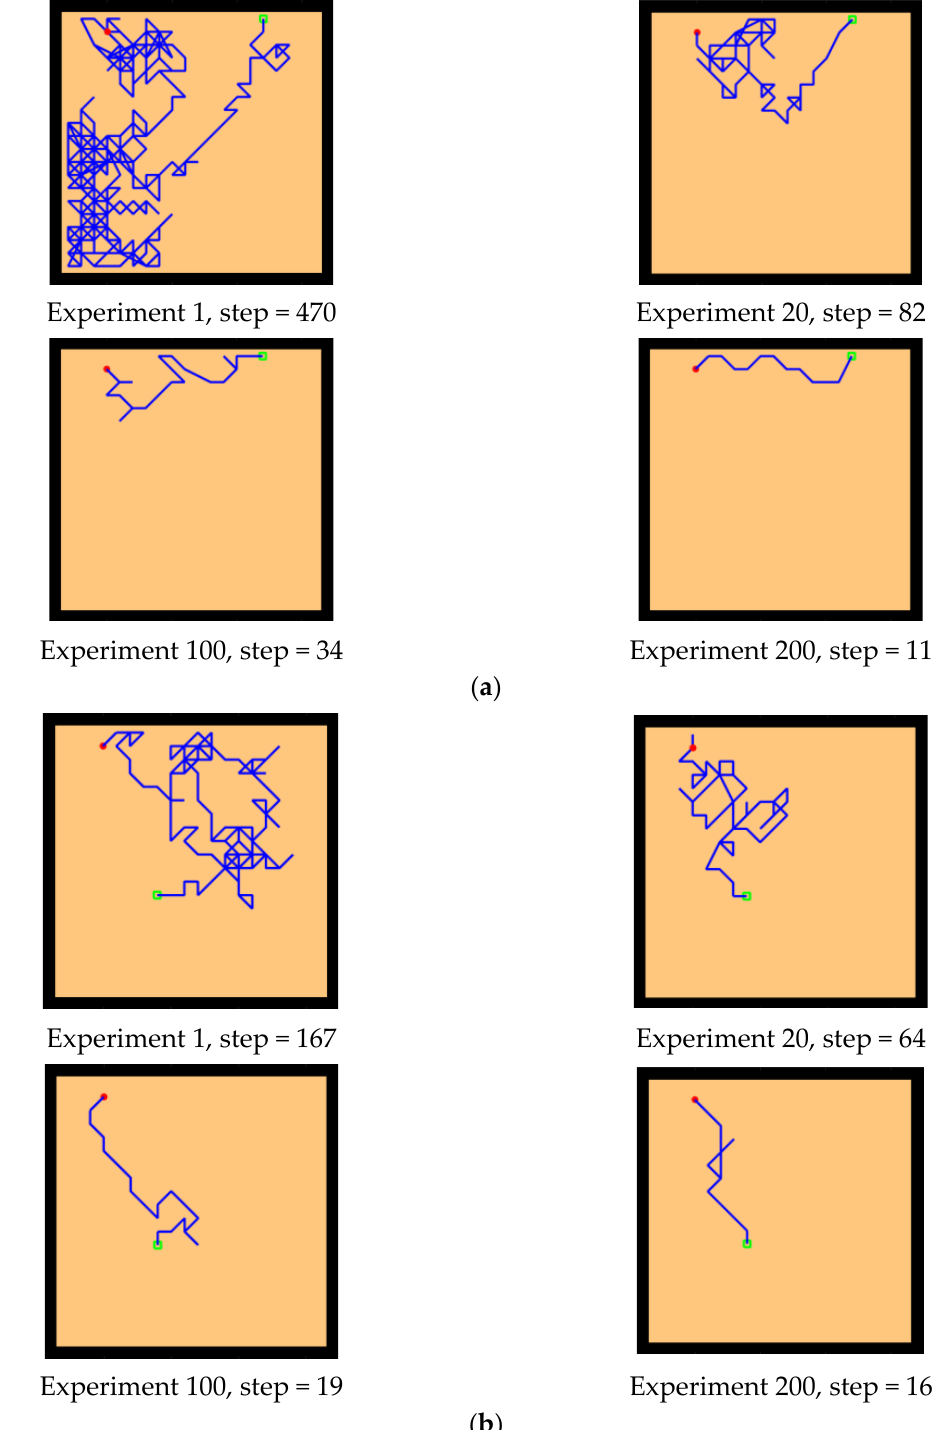
Figure 11. Basic experiment. The position of the starting point remains unchanged, and the position of the survival platform changes. Two groups of experiments: ( a , b ). ( a ) survival platform A, ( b ) survival platform B.